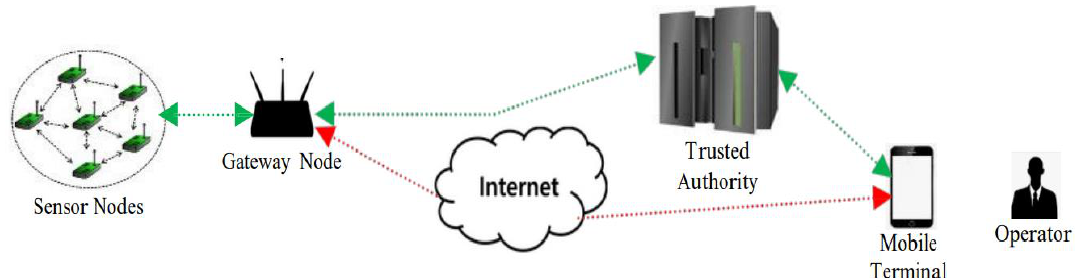
Figure 1. Network Architecture. Table 1. Deployed